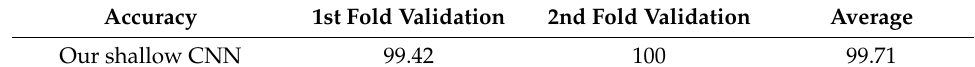
Table 6. Classification accuracies by our shallow CNN (unit: %).